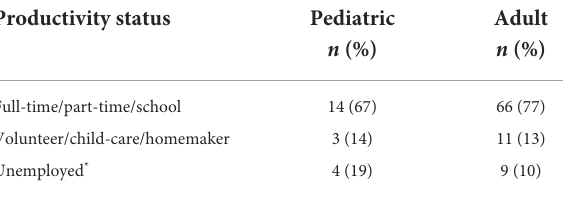
TABLE 4 Relationship between acquired brain injury onset and MPAI-4